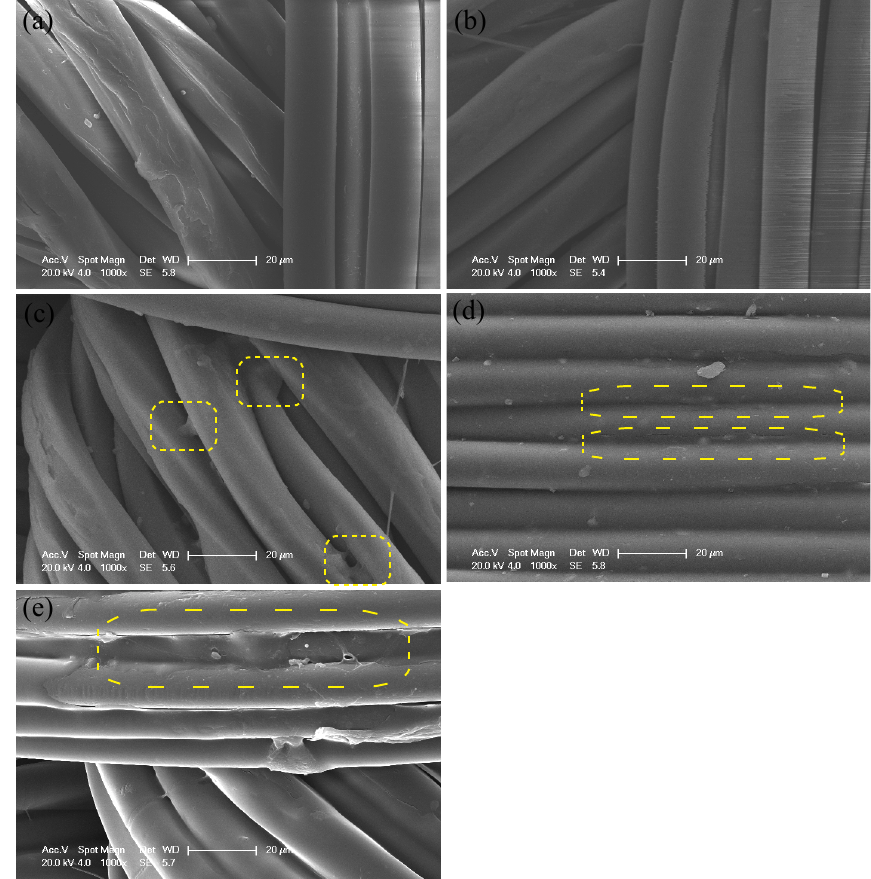
Figure 2. SEM images of Poly(ethyleneterephthalate) (PET) before ( a ) and after deposition of 1 bilayer ( b ); 3 bilayers ( c ); 5 bilayers ( d ) and 7 bilayers ( e ).